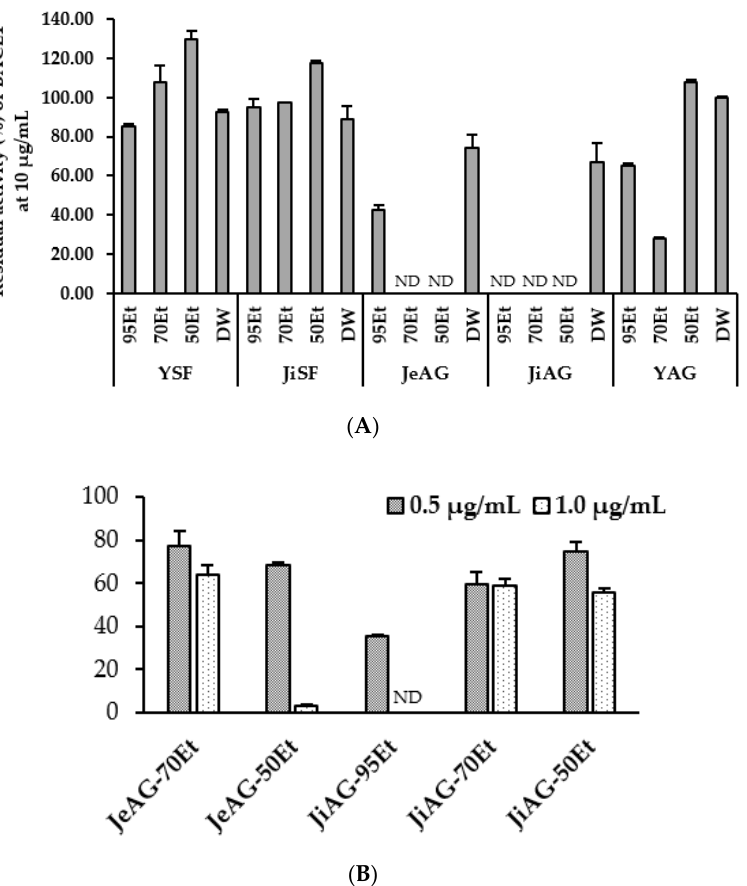
Figure 6. Inhibition of BACE1 by the extracts at 10 μg/mL ( A ) and 1.0 or 0.5 μg/mL ( B ). Activity of BACE1 was observed by FRET-assay using the BACE1 activity detection kit. ND, not-detectable due to its negative value. Table 2. Inhibitions of the extracts for DPPH radical scavenging activity and A β